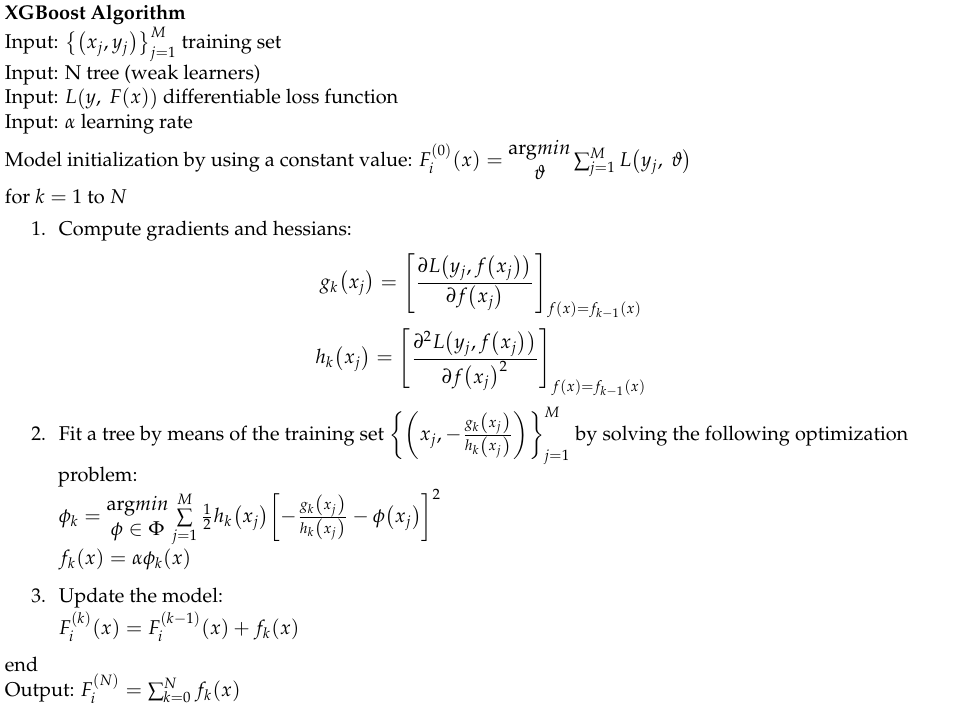
Algorithm 1 Pseudocode of the unregularized XGBoost algorithm XGBoost